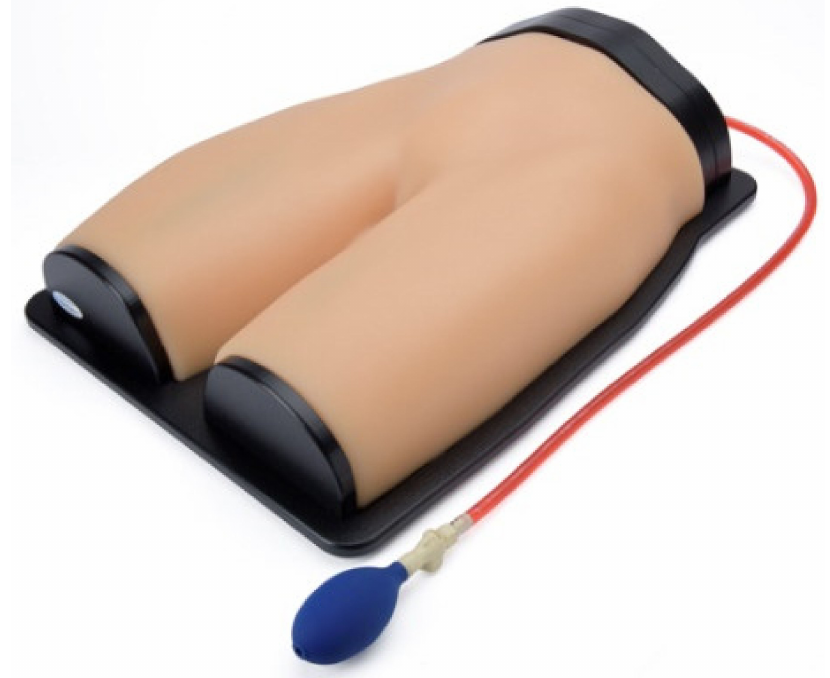
Figure 15. Femoral region cardiac catheterization simulator [26].